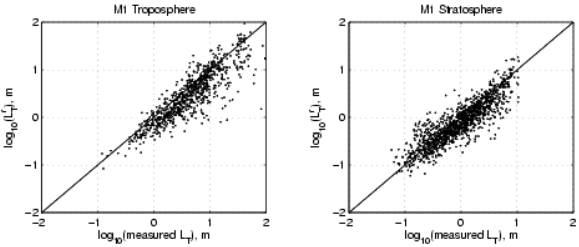
Fig. 2. Comparisons of directly measured and estimated Eq. (13) Figure 2. Comparisons of directly measured and estimated with eq. (13) Thorpe lengthscales Thorpe lengthscales for the troposphere, below 11.5km (left), and for troposphere, below 11.5 km (left) and stratosphere above 11.5 km (right) during flight M1. the stratosphere, above 11.5km (right), during flight